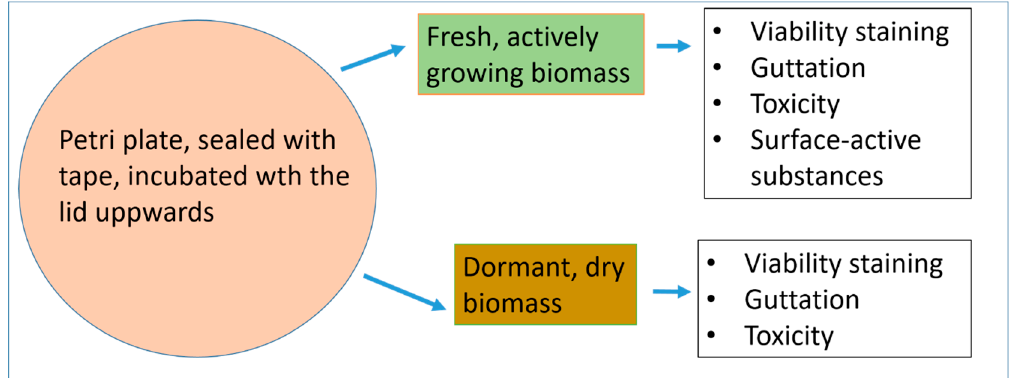
Figure 1. Experimental procedure for comparison of metabolic activity in fresh, actively growing and old, dormant, dry fungal biomass. The investigated biomass was produced by cultivation on malt extract agar, on gypsum liner, or on a piece of exhaust filter. Fresh, actively growing, and dormant, dry biomasses were incubated for 1 to 3 weeks, and 5 to 6 months, respectively.